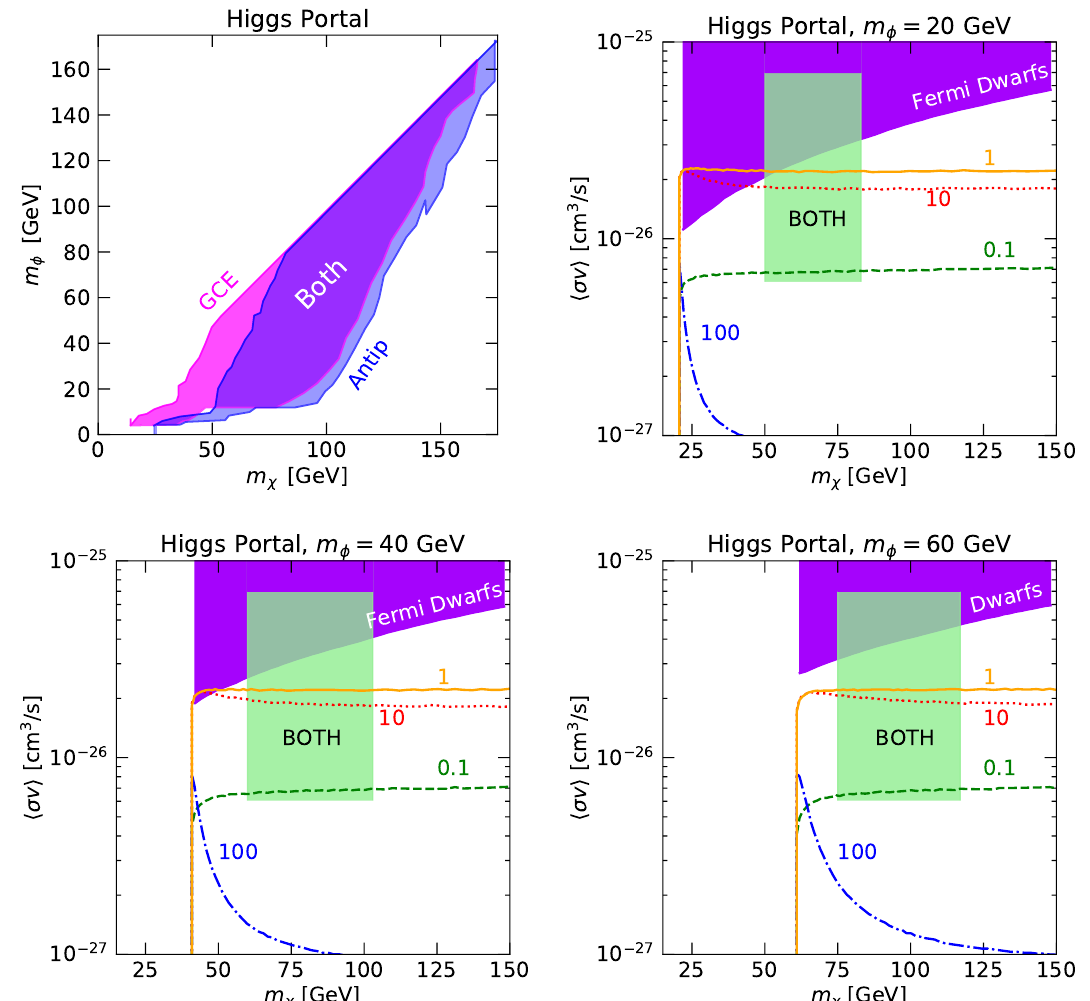
Figure 8 . As in the previous three (cid:12)gures, but for the case of hidden sector dark matter that annihilates to particles that decay through the Higgs portal. Each line corresponds to a di(cid:11)erent ratio of the scalar and pseudoscalar couplings, (cid:21) s =(cid:21) p . This class of models provides the largest regions of parameter space that can accommodate both